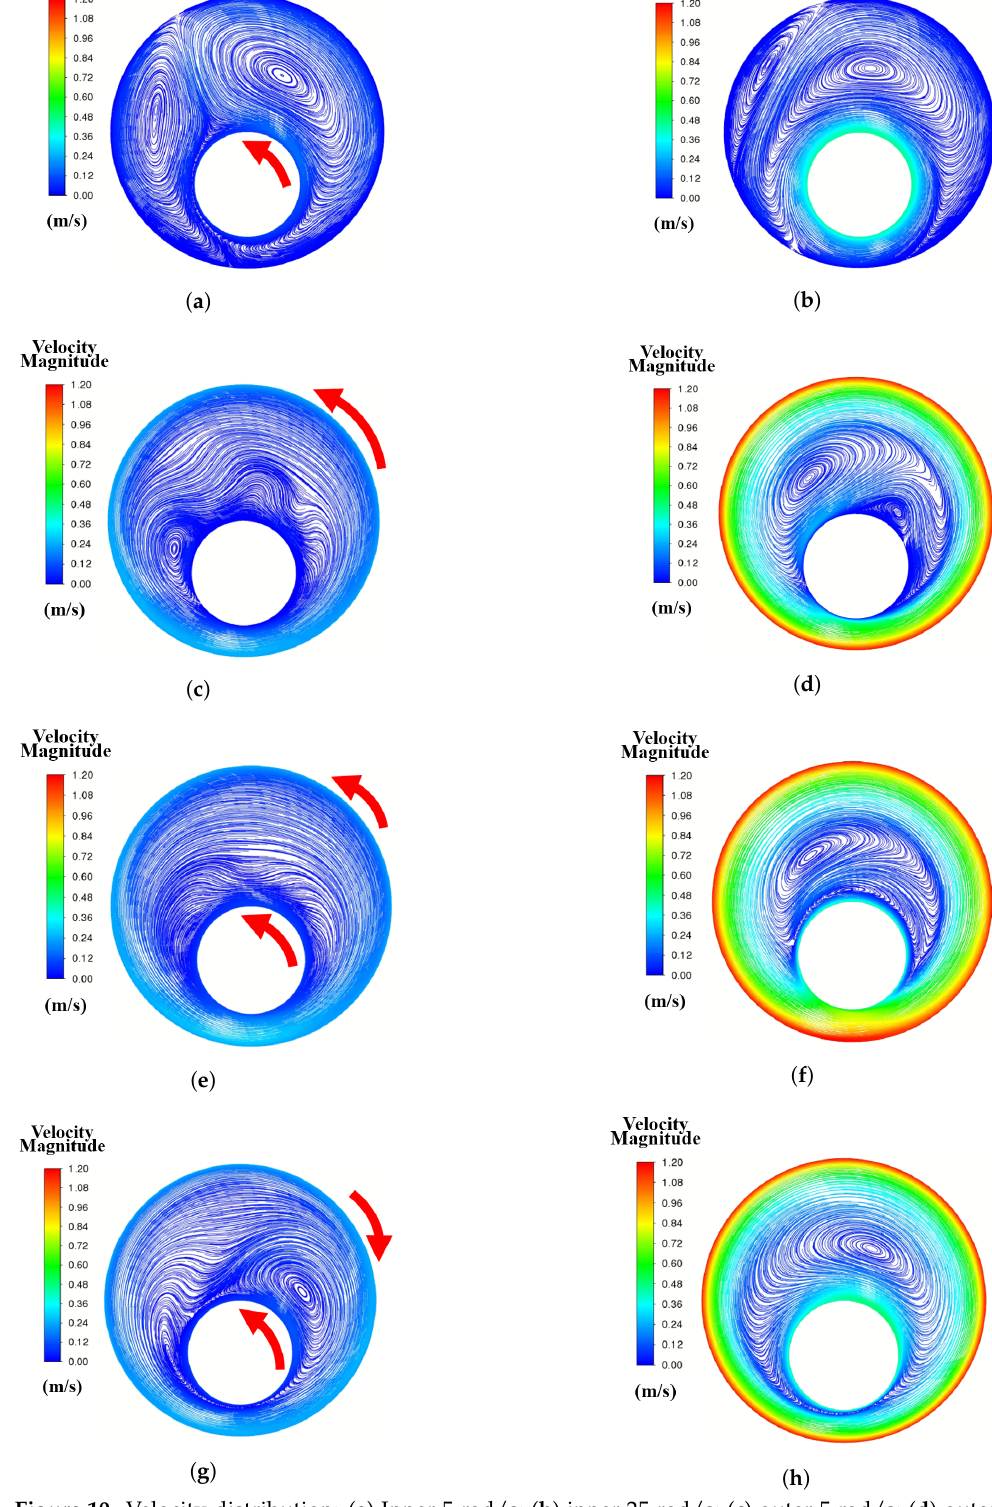
Figure 10. Velocity distribution: ( a ) Inner 5 rad/s; ( b ) inner 25 rad/s; ( c ) outer 5 rad/s; ( d ) outer 25 rad/s; ( e ) outer 5 rad/s, inner 5 rad/s; ( f ) inner 25 rad/s, outer 25 rad/s; ( g ) inner 5 rad/s, outer − 5 rad/s; and ( h ) inner 25 rad/s, outer − 25